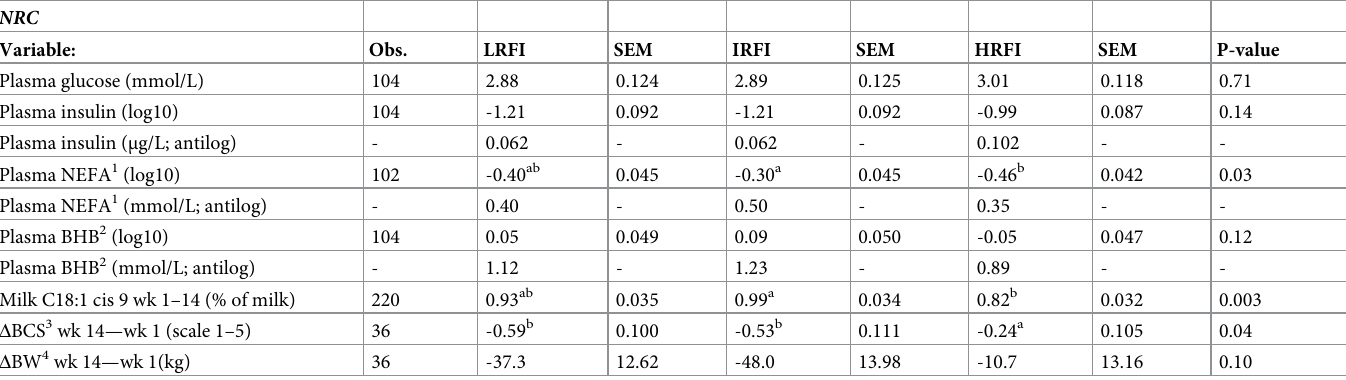
Table 3. Metabolic and related variables (mean and SEM) in cows in early lactation divided into three groups, with low residual feed intake (LRFI; n = 12), interme- diate (IRFI; n = 12) or high RFI (HRFI; n = 12) according the NRC (2011) equation. The plasma variables sampled in lactation week 2, 4, and 6.